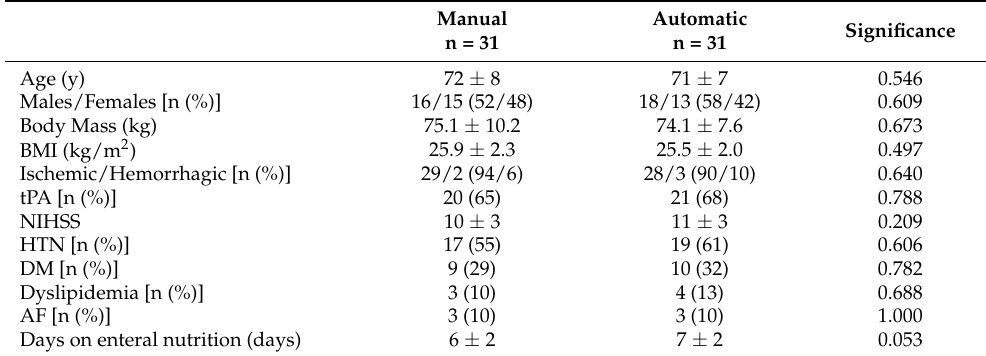
Table 1. Demographics and clinical characteristics of the included acute-stroke patients (n = 62) in the manual and automatic flushes pumps groups. Means ± standard deviations and proportions.